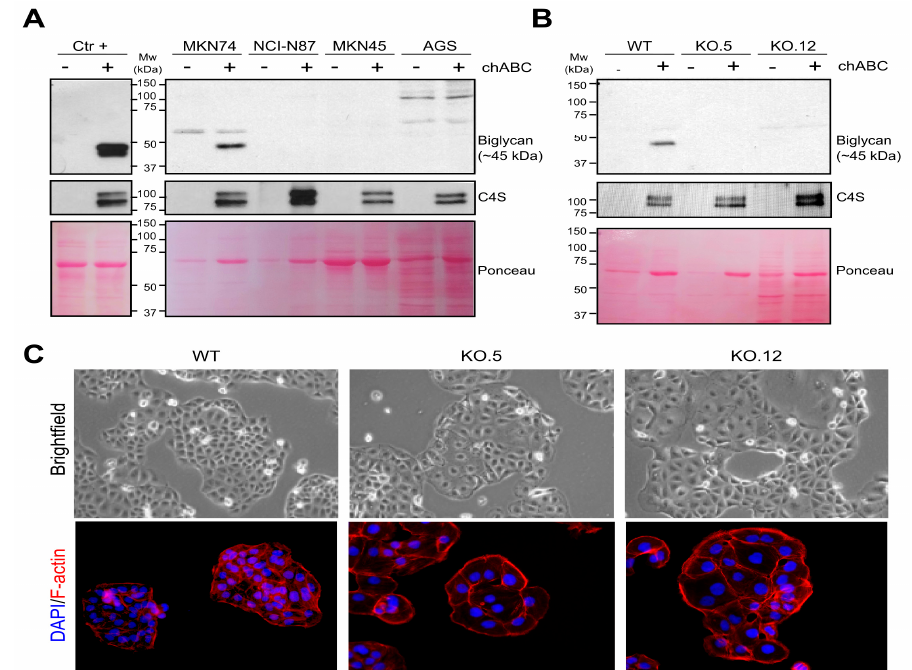
Figure 3. Characterization of biglycan expression in different GC cell lines and in knock out (KO) cells. ( A ) Biglycan expression in secretome samples from an intestinal cancer cell line Caco-2 (positive control) and from four GC cell lines (MKN74, MKN45, NCI.N87, and AGS) with and without chondroitinase ABC (chABC) treatment. Western blot analysis show MKN74 as the only GC cell line positive for biglycan. ( B ) Biglycan immunodetection in the MKN74 WT and KO cells (clones KO.5 and KO.12), showing the loss of expression in both KO clones. Chondroitinase-4-sulfate (C4S) immunedetection was used as a positive control for the chABC enzymatic treatment in all analysis. An increase in the C4S detection is expected after glycosaminoglycan (GAG) digestion by chABC. Ponceau staining was used as a loading control for secretome samples. ( C ) Bright field microscopy pictures (Magnification at 400 × ) and F-actin (red—phaloidin) immunofluorescence in MKN74 WT and biglycan KO cell (clones KO.5 and KO.12). Biglycan KO cells present morphological differences when compared with WT